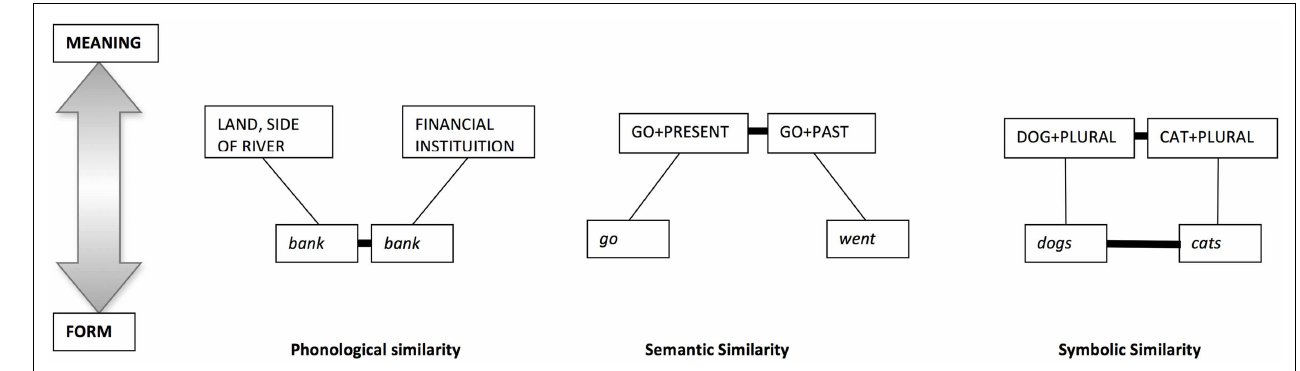
FIGURE 1 | Constructions grouped together on the basis of similarity of form and/or function (adapted from Croft and Cruse,